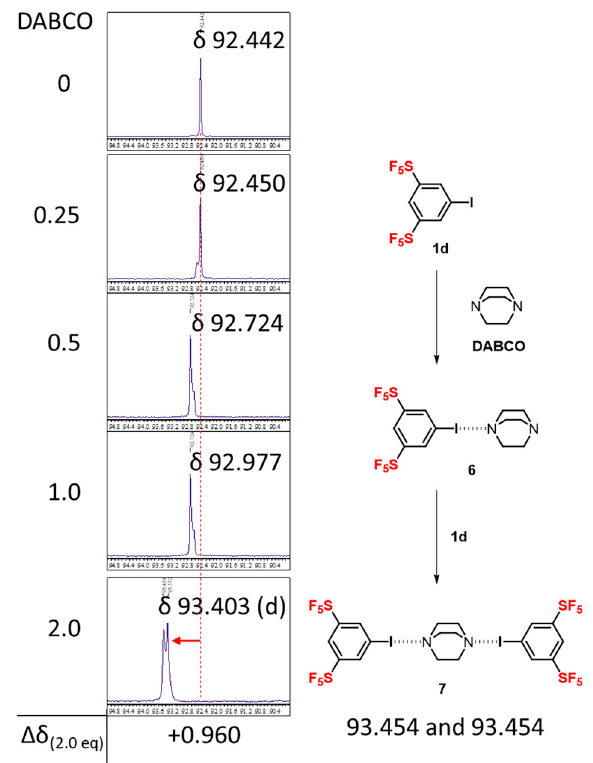
Figure 6. Change in the 13 C-NMR chemical shift of the carbon atom bonded to iodine in 1d with equivalents of 1,4-diazabicyclo[2.2.2]octane (DABCO) in CDCl 3 .